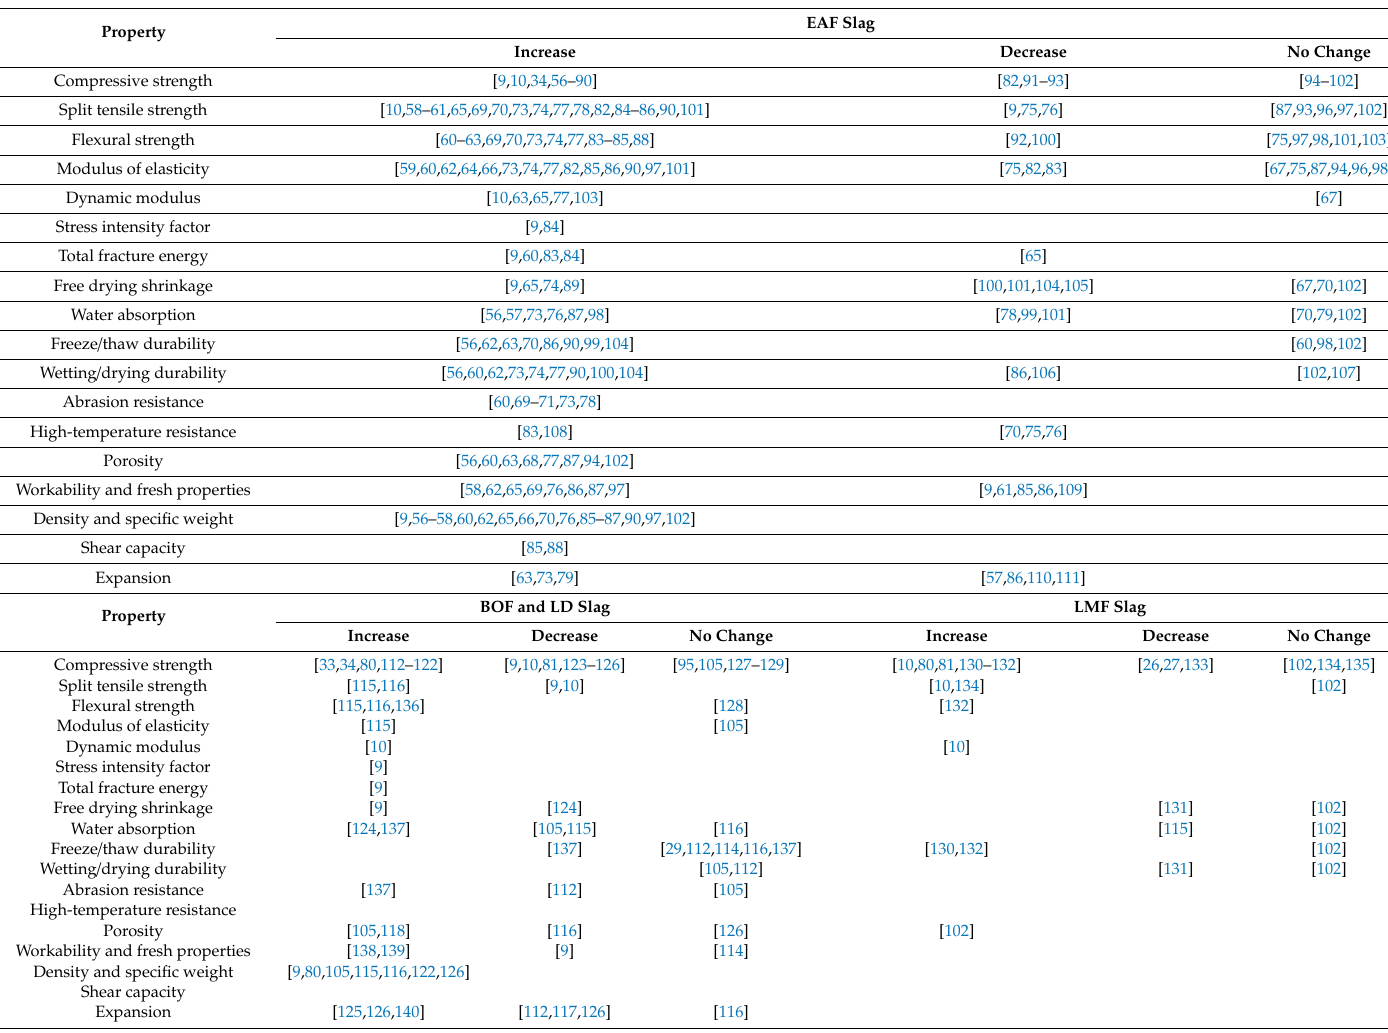
Table 2. E ff ect of SFS used as a partial to full replacement of virgin coarse and / or fine aggregate in portland cement concrete relative to the control with virgin